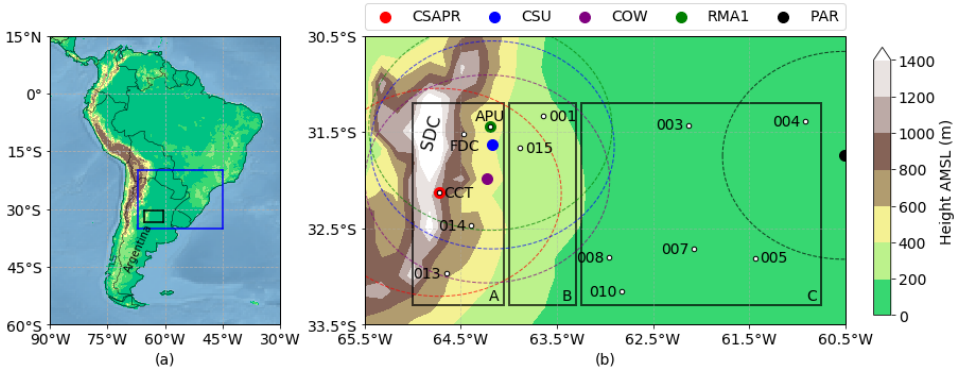
Figure 1. ( a ) Location of the study area in South America indicated by the black box. Southeastern South America (SESA) denoted with a blue box. ( b ) Locations of the thirteen disdrometers analyzed. The shading indicates the height above mean sea level (AMSL) of the Sierras de Córdoba (SDC). The colored markers show the positions of the available radars: the C Scanning ARM Precipitation Radar (CSAPR 2), the Colorado State University C-band Hydrological Instrument for Volumetric Observation (CSU-CHIVO, hereafter CSU), the CSWR C-band on wheels (COW), the Radar Mete- orologico Argentino 1 (RMA1), and the Parana C band radar (PAR). The dotted line rings indicate the 120 km range of each radar. The black boxes show the three regions into which the study area was